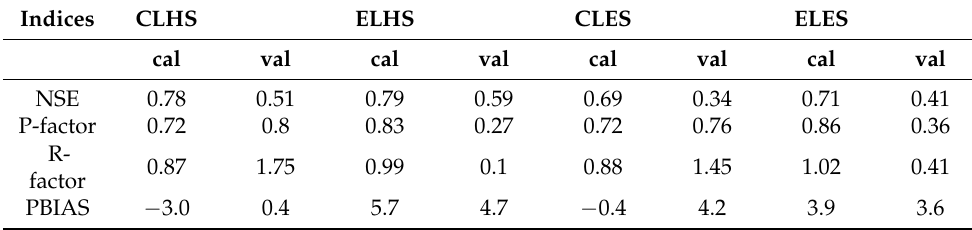
Table 4. Results of goodness-of-fit evaluation for calibration and validation